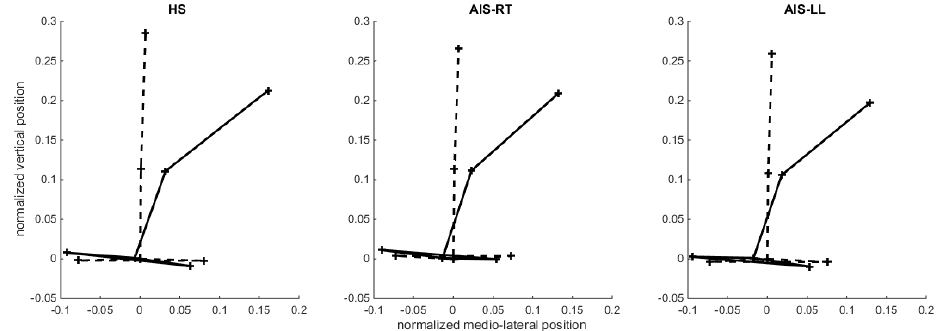
Figure 2. Back view of the spine in lateral bending. Plot of the back view (frontal) of the mean normalized positions of the spine (sacrum, inflexion point, and T1) and the pelvis (antero-superior iliac spines) at the beginning (dotted line) and at the end (solid line) of the lateral bending for the HS, AIS-LL, and AIS-RT groups.